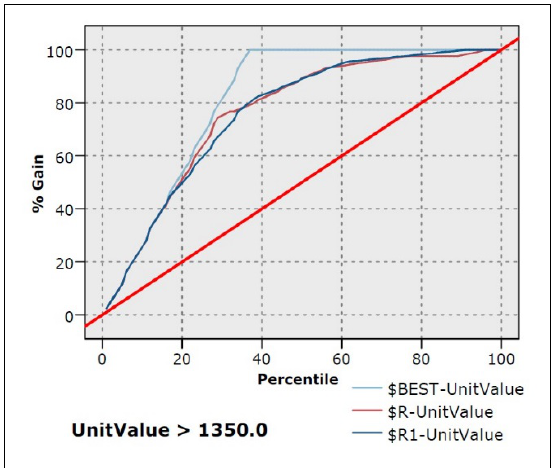
Fig. 13. C&RT ( R ) and CHAID ( R 1) comparison chart (developed by the